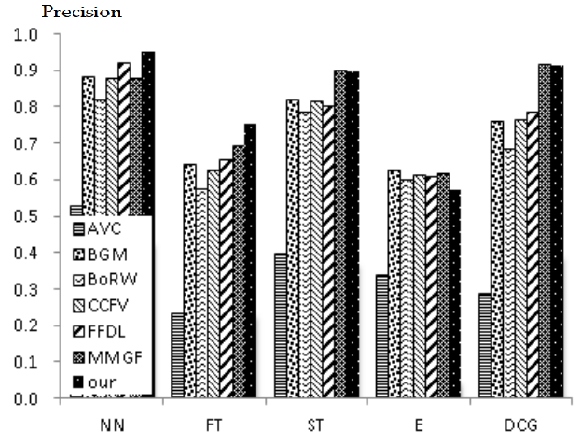
Figure 8. The five evaluation criteria of five different methods and ours.